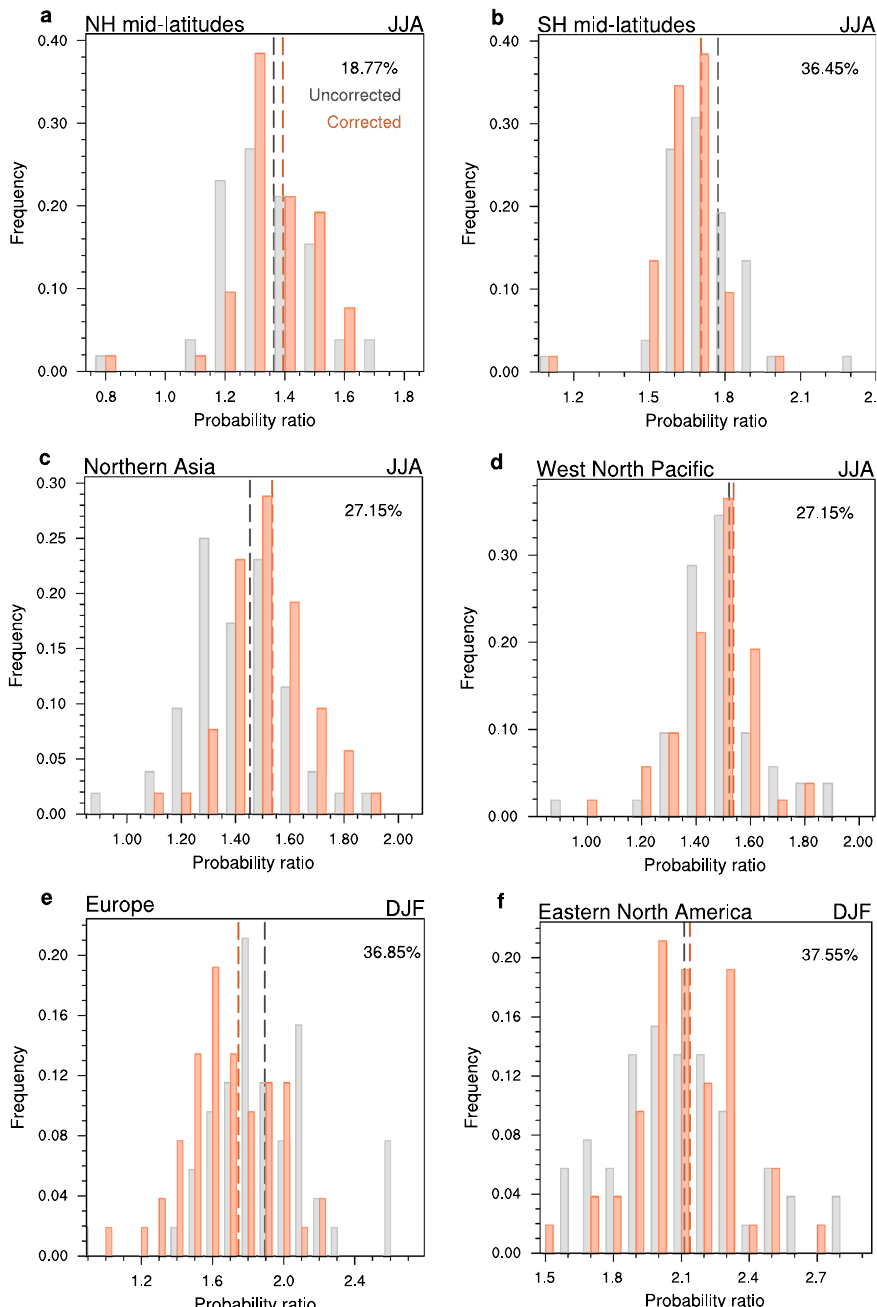
Fig. 3 | Constrained extreme precipitation projections. Unconstrained (gray) versus constrained (orange) projections of probability ratios of extreme pre- cipitation (95th percentile of pr5d) under a 3°C global warming increment in the joint ensemble of CMIP5 and CMIP6 (Coupled Model Intercomparison Project Phases 5 and 6). The histograms show the fraction of models with a certain prob- ability ratio. Dashed verticallinesindicate the multi-modelensemblemedians. The